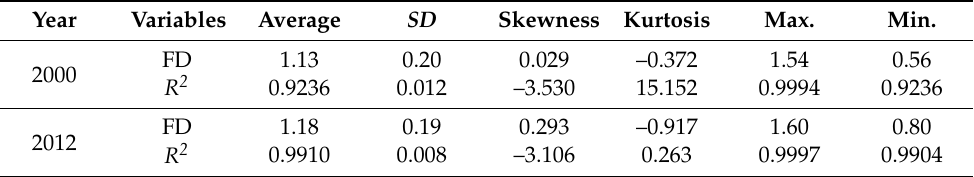
Table 2. Characteristics of FD in Fujian